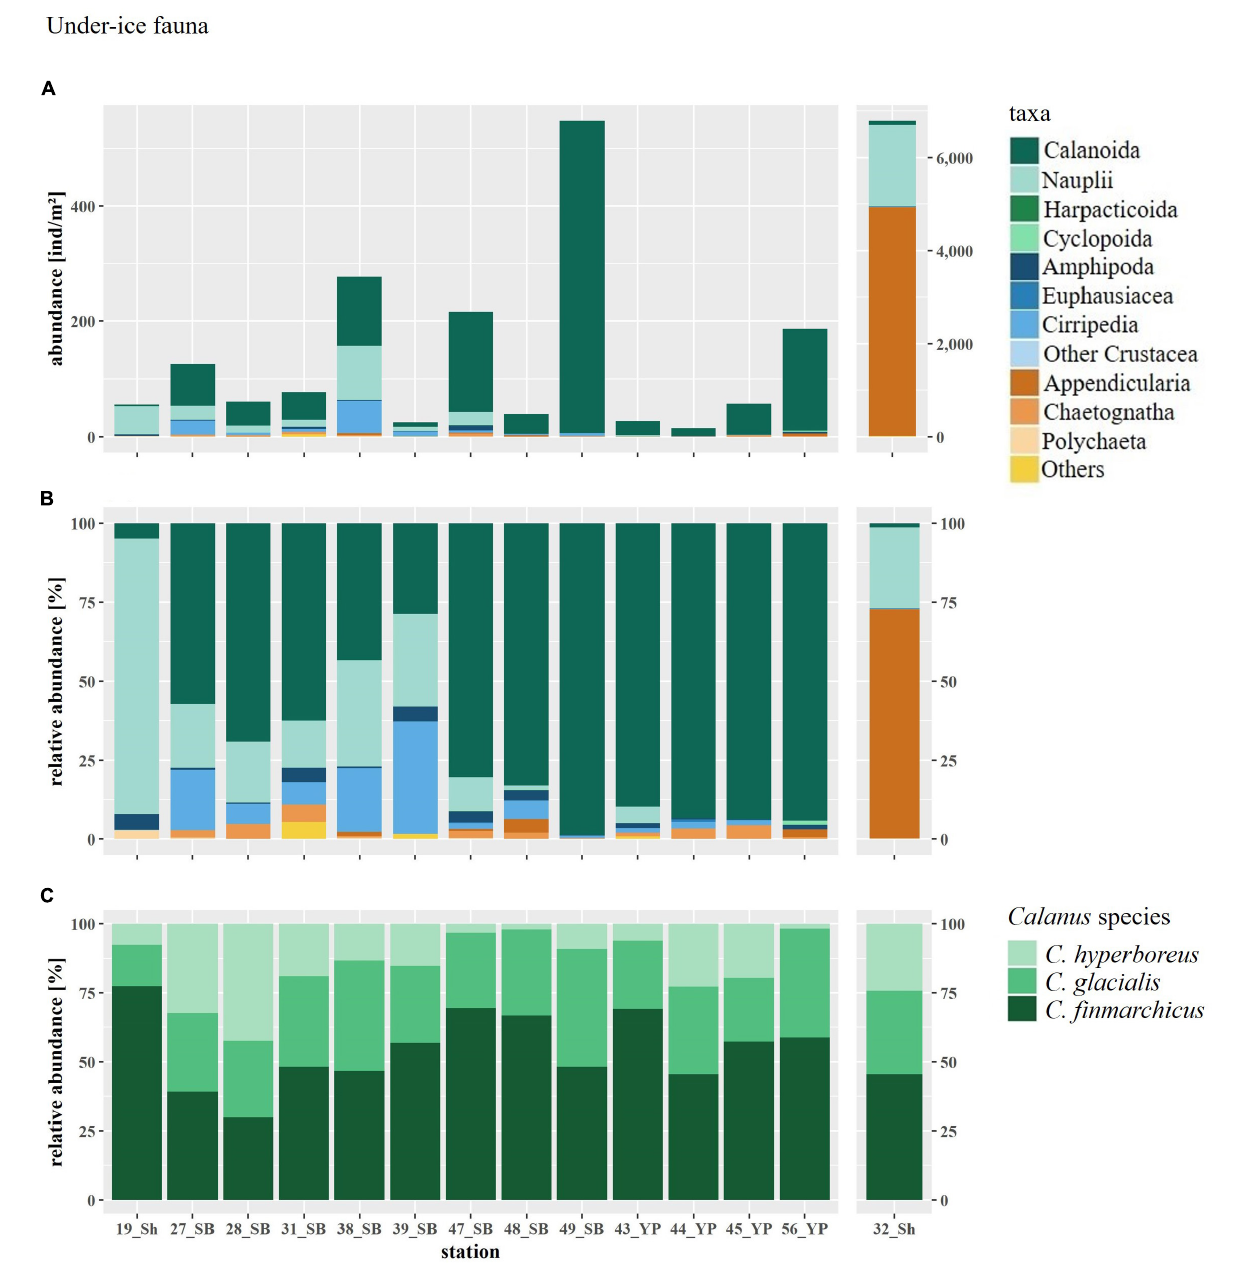
FIGURE 8 | (A) Abundance and (B) relative abundance of the under-ice fauna and (C) relative abundance of the three Calanus species at SUIT stations arranged by geographical region (Sh, shelf; SB, Sophia Basin; YP, Yermak Plateau). SUIT Station 32 has a different y -axis, because of high Appendicularia abundance. “Others” includes the rare taxa Hydrozoa, Osteichthyes larvae, Xenacoelomorpha, Clione limacina , Limacina helicina . “Other Crustacea” includes Isopoda and Zoaea